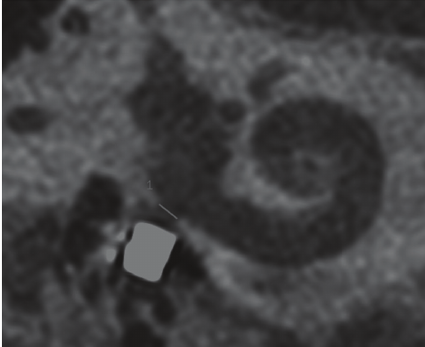
Figure 4: Type II coupling—FMT in RW niche, no direct contact.